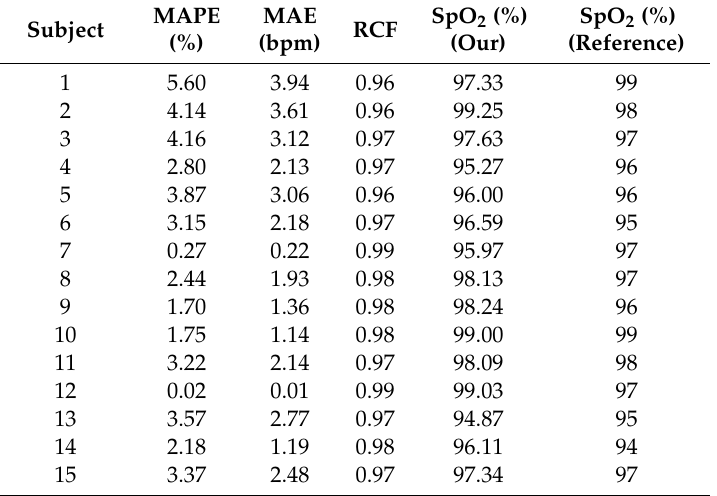
Table 2. Performance of our proposed wearable pulse oximeter device without motion condition. MAE, mean absolute error; MAPE, mean absolute percentage error; RCF, reference closeness factor.